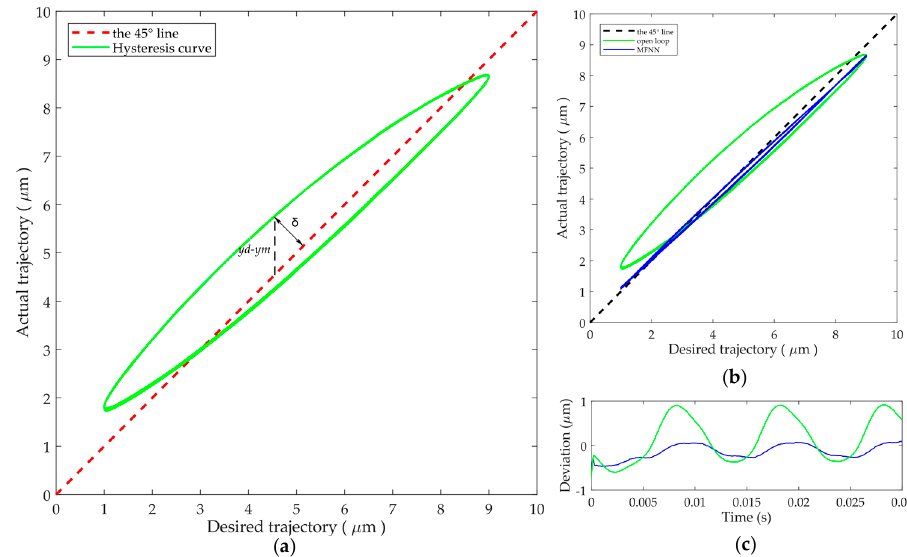
Figure 6. The definition of the deviation used for the evaluation of hysteresis compensation performance: ( a ) the definition; ( b ) the conventional hysteresis plot; and ( c ) the deviation plot.